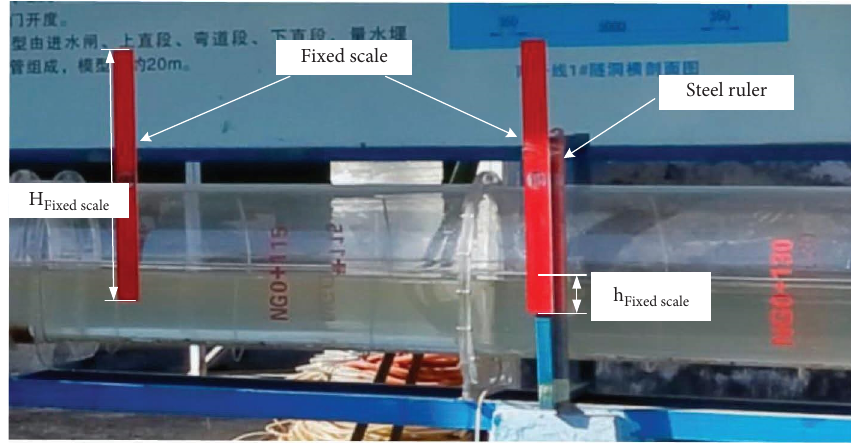
Figure 4: A schematic diagram of water level measurement. Table 1: Te position number of each fxed scale and the elevation of the bottom edge of the scale. Fixed scale